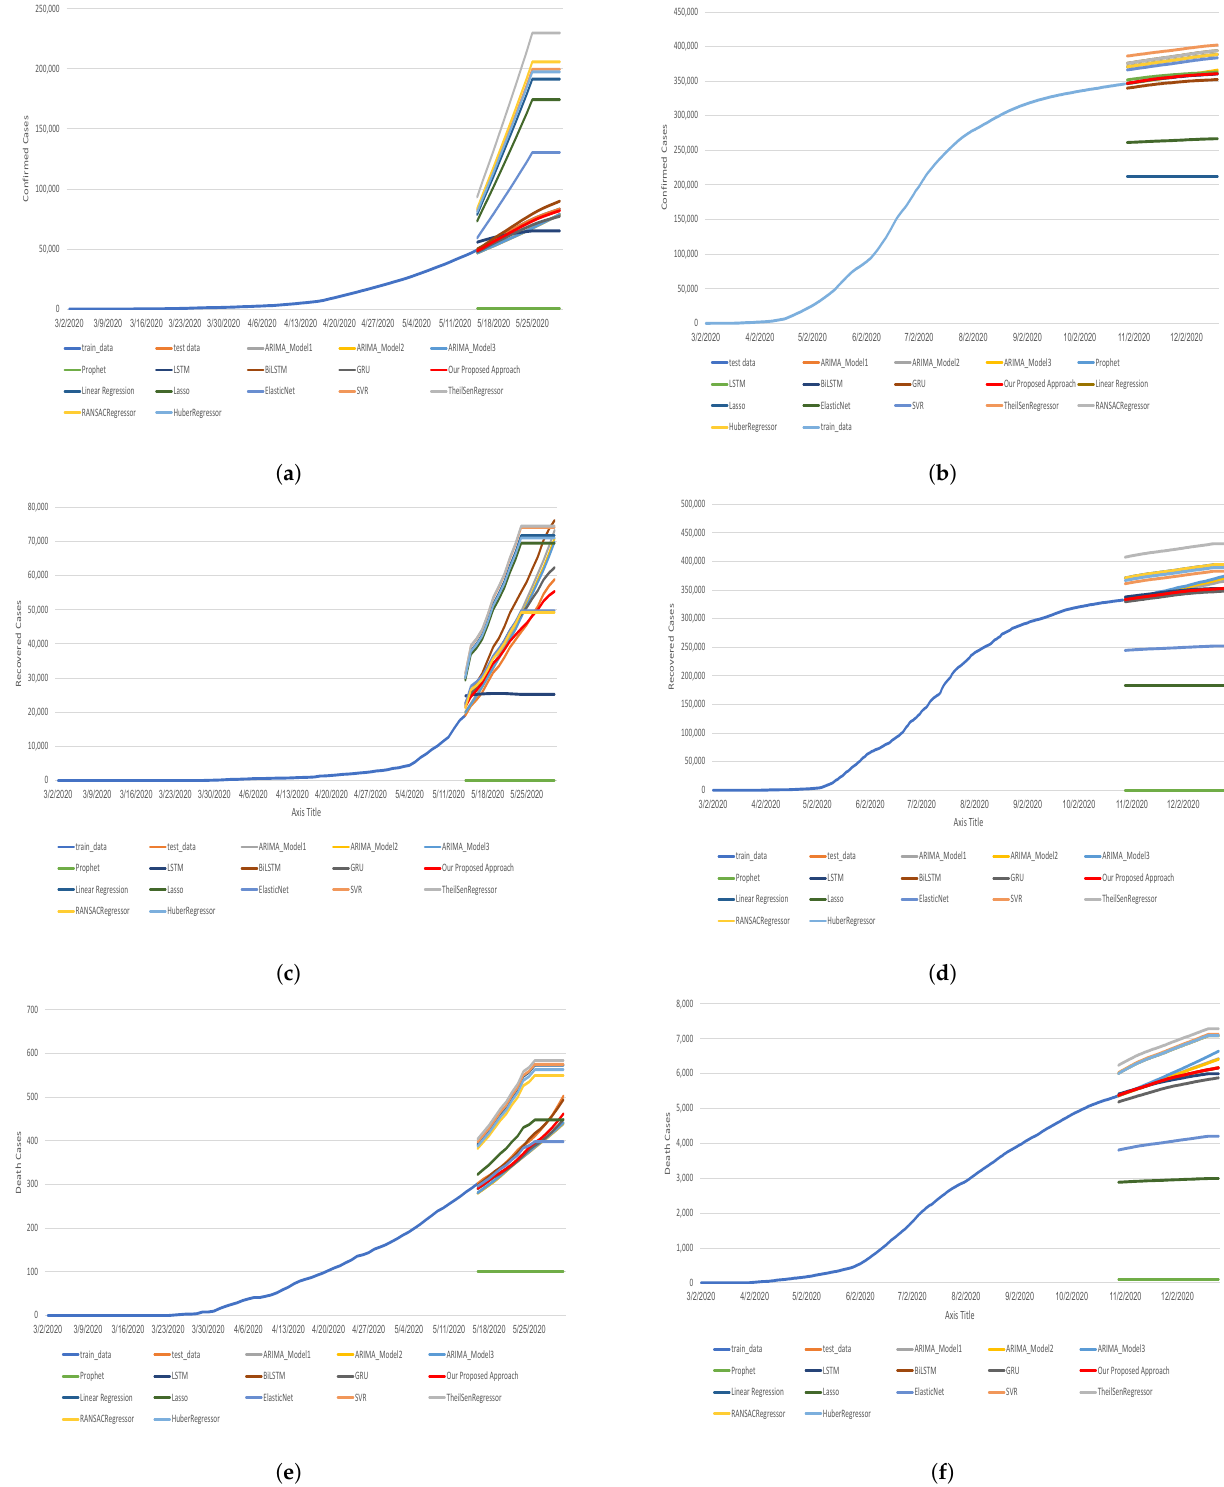
Figure 6. The forecasting results of our proposed method vs. the previous methods for confirmed, recovered, and death cases in Saudi Arabia. ( a ) Confirmed case forecasting results in the starting of the first COVID-19 wave in Saudi Arabia. ( b ) Confirmed case forecasting results in the ending of the first COVID-19 wave in Saudi Arabia. ( c ) Recovered case forecasting results in the starting of the first COVID-19 wave in Saudi Arabia. ( d ) Recovered case forecasting results in the ending of the first COVID-19 wave in Saudi Arabia. ( e ) Death case forecasting results in the starting of the first COVID-19 wave in Saudi Arabia. ( f ) Death case forecasting results in the ending of the first COVID-19 wave in Saudi